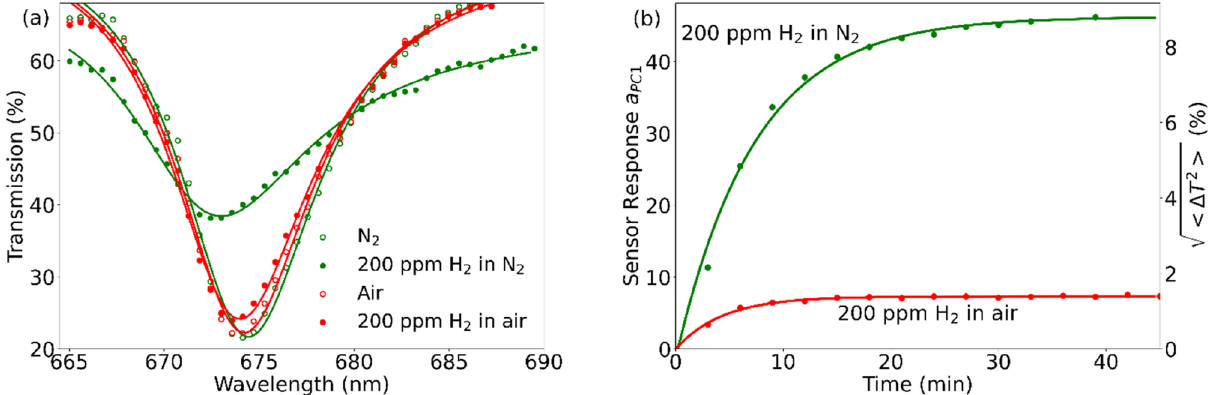
Figure 3. Sensor response to 200 ppm hydrogen in nitrogen or in air: spectral response ( a ) and time-dependent response ( b ) shown in terms of the amplitude of the first principal component, a PC 1 , and of a corresponding average spectral change in transmittance, (right scale). Curves show the exponential fit of the experimental data. The spectra are measured in the E ⊥